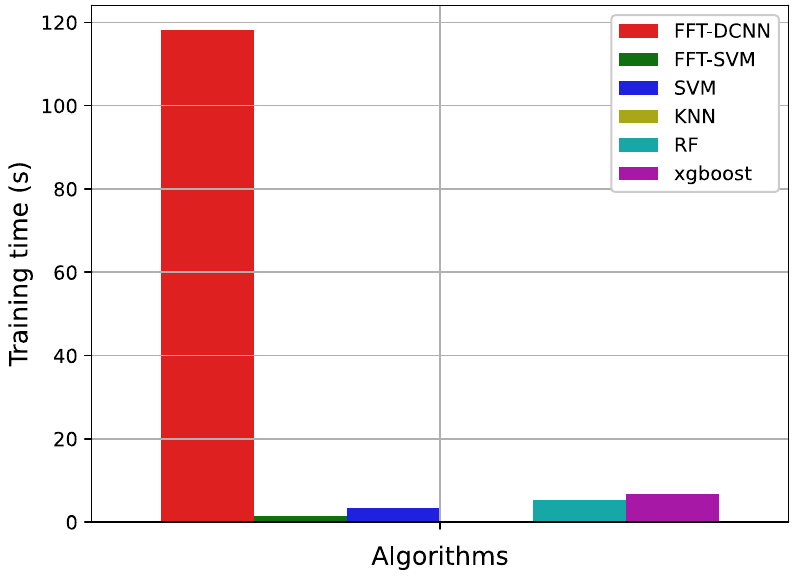
Figure 13. Comparison of training time between the proposed method and ML algorithms.